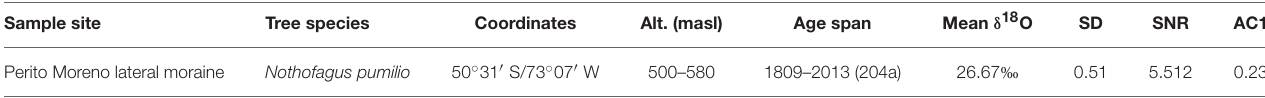
TABLE 1 | General site characteristics and δ 18 O Tree − ring -chronology statistics of the Perito Moreno Glacier sampling site. Sample